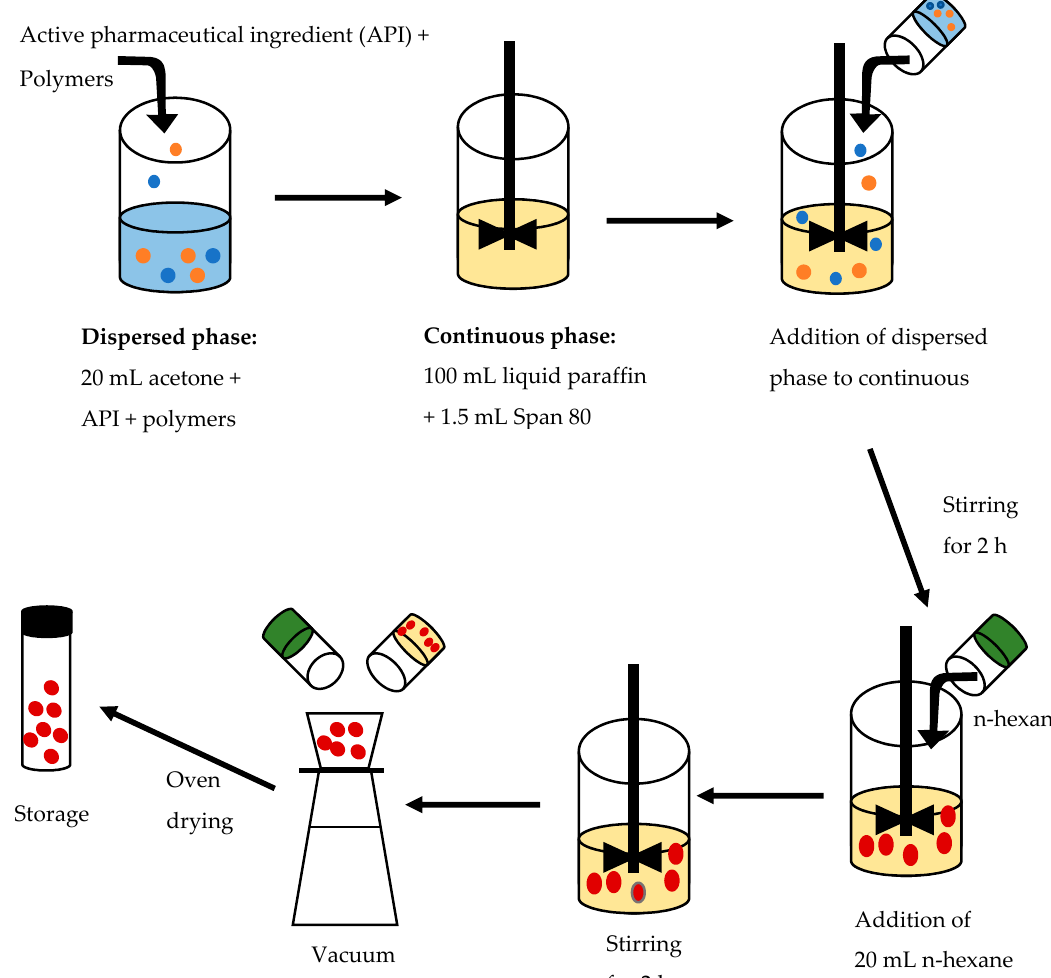
Figure 1. Schematic representation of the solvent evaporation process for the manufacture of hydrochlorothiazide (HCTZ) microparticles.